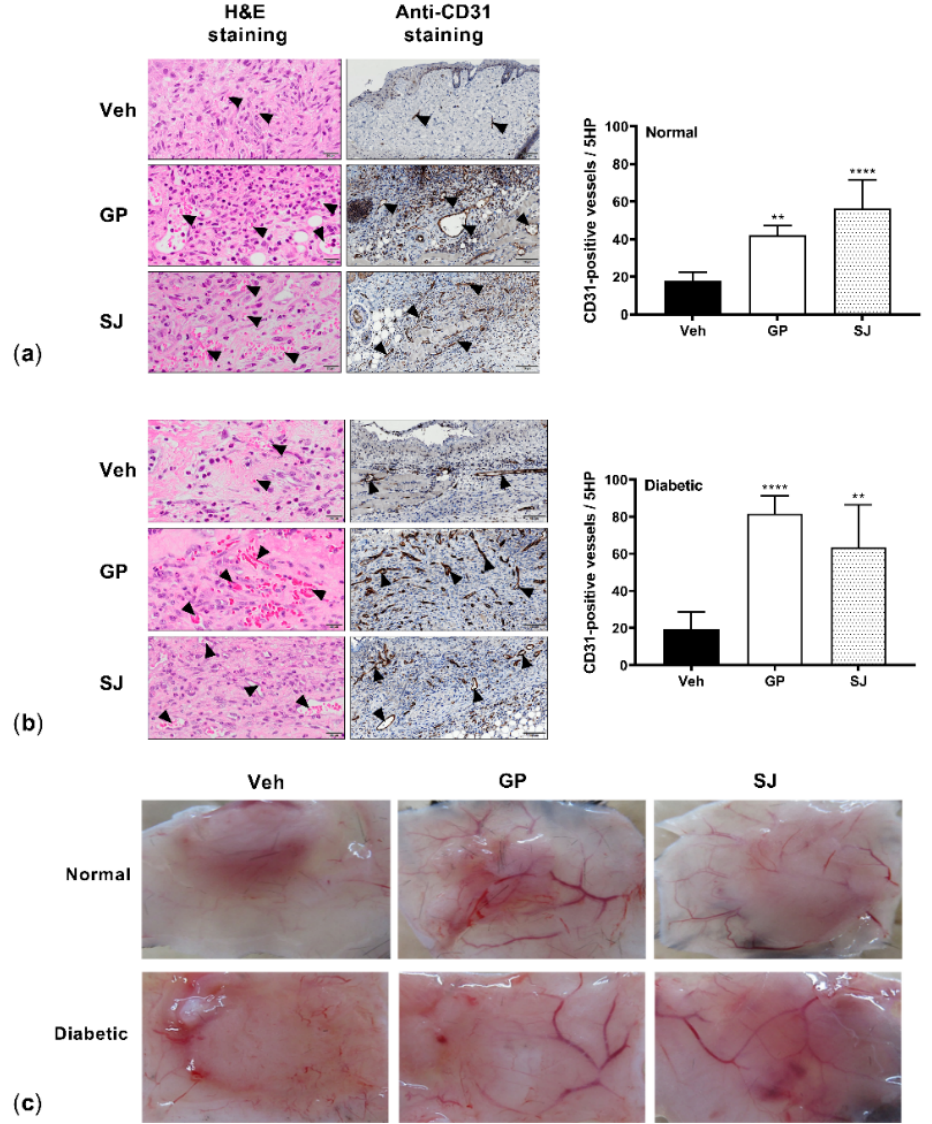
Figure 5. G. procumbens promotes blood vessel formation: Representative images of wounds from ( a ) normal and ( b ) diabetic mice treated with Vaseline (Veh: vehicle), 0.5% G. procumbens (GP) or